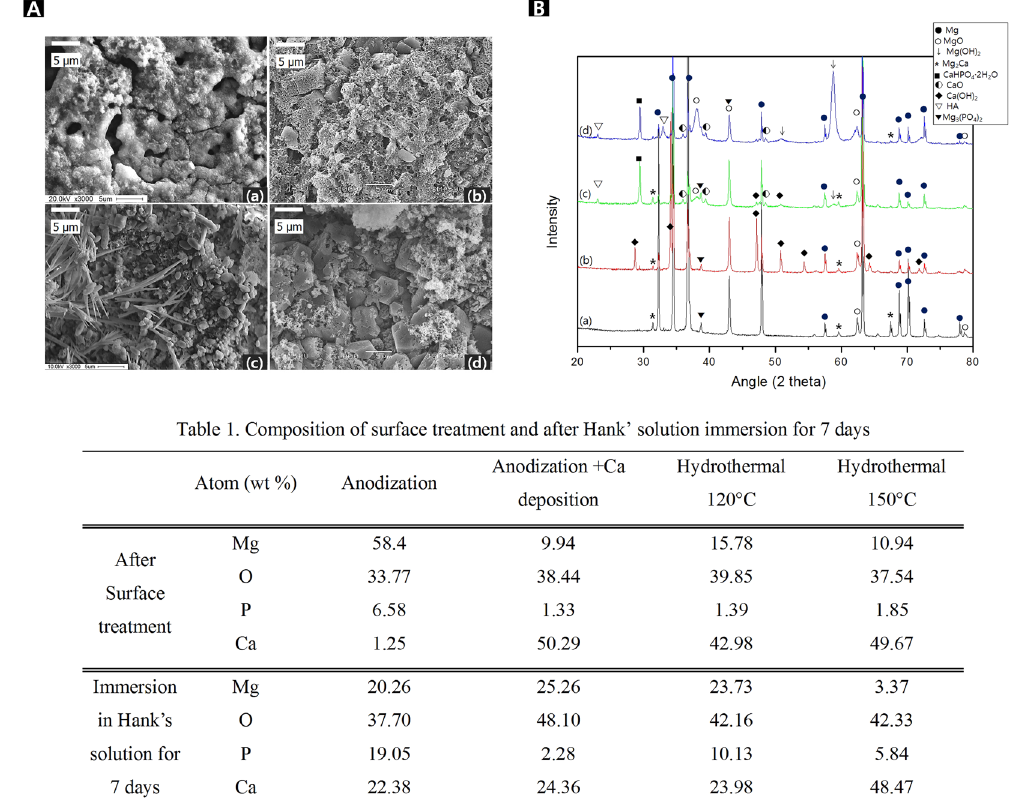
Figure 2. Surface morphology ( A ) and XRD patterns ( B ) of (a) anodization on AZ31B-1.5Ca (b) Ca deposition after anodizing (c) hydrothermal treatment at 120 °C, (d) hydrothermal treatment at 150 °C, and Compositions of specimens after the surface treatment and after immersion in Hank’ solution for 7 days, and composition of surface after treatment and SBF immersion ( C